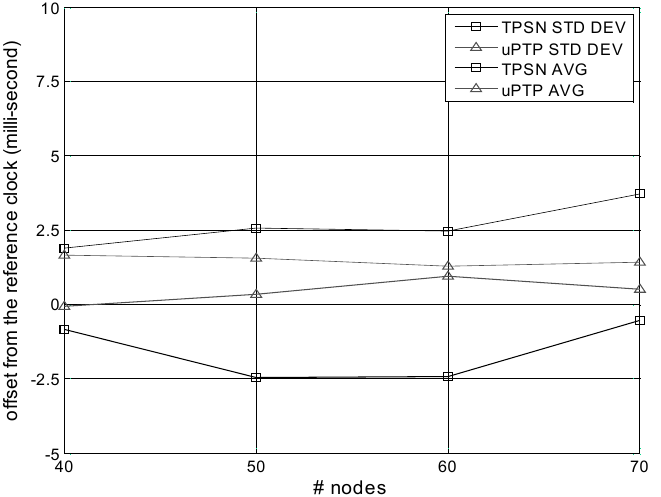
Figure 10. Accuracy and precision vs . number of